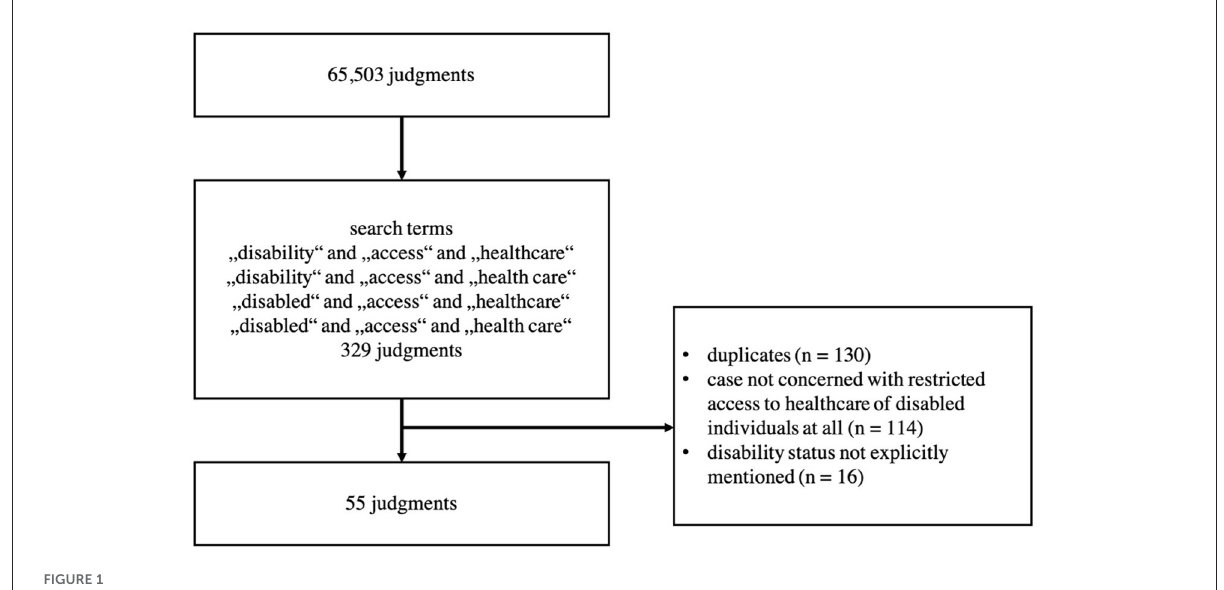
FIGURE1 Flowchart of the search.